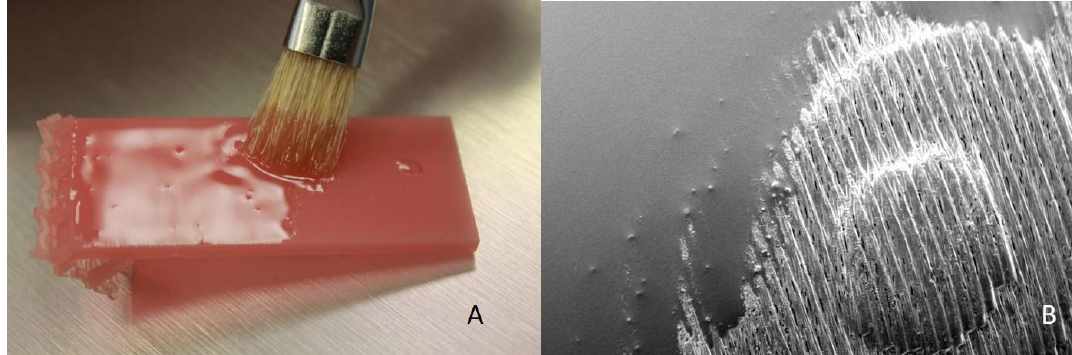
Figure 8. ( A ): Coating of the printed specimens with the unpolimerized resin from the 3D printer using a fine brush; ( B ): REM image of the coating application. The liquid unpolimerized resin flattens the staircase effect of the printed specimens.